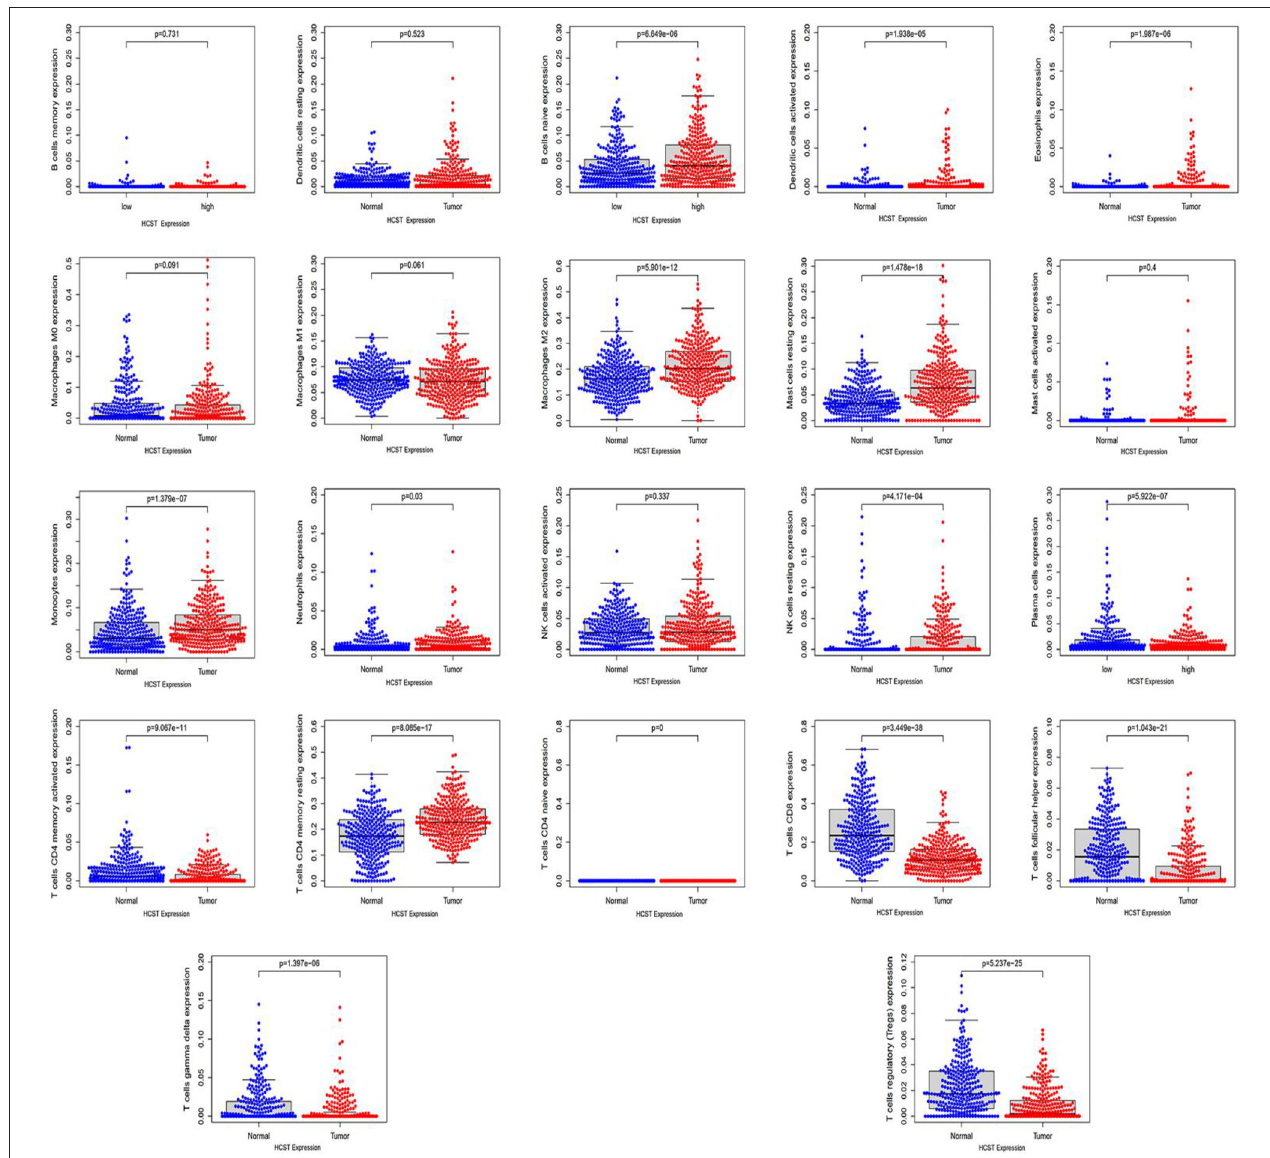
FIGURE 9 | HCST was significantly correlated with tumor-infiltrating immune cells in ccRCC. Analysis of the TCGA dataset via the LM22 signature matrix using CIBERSORT online. In total, 22 kinds of tumor-infiltrating immune cells are plotted according to the HCST expression level. There were significant differences in naïve B cells, activated DCs, eosinophils, M2 macrophages, resting mast cells, monocytes, neutrophils, resting NK cells, plasma cells, activated CD4 memory T cells, resting CD4 memory T cells, CD8T cells, follicular helper T cells, gamma delta T cells, and regulatory T cells (all, p < 0.001).